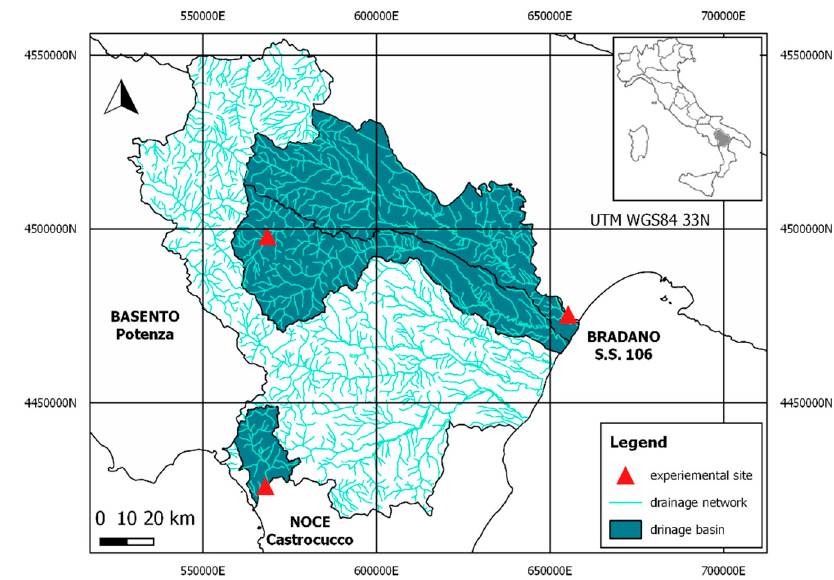
Figure 1. Location of monitoring sites. Remote Sens. 2020 , 12 , 1789